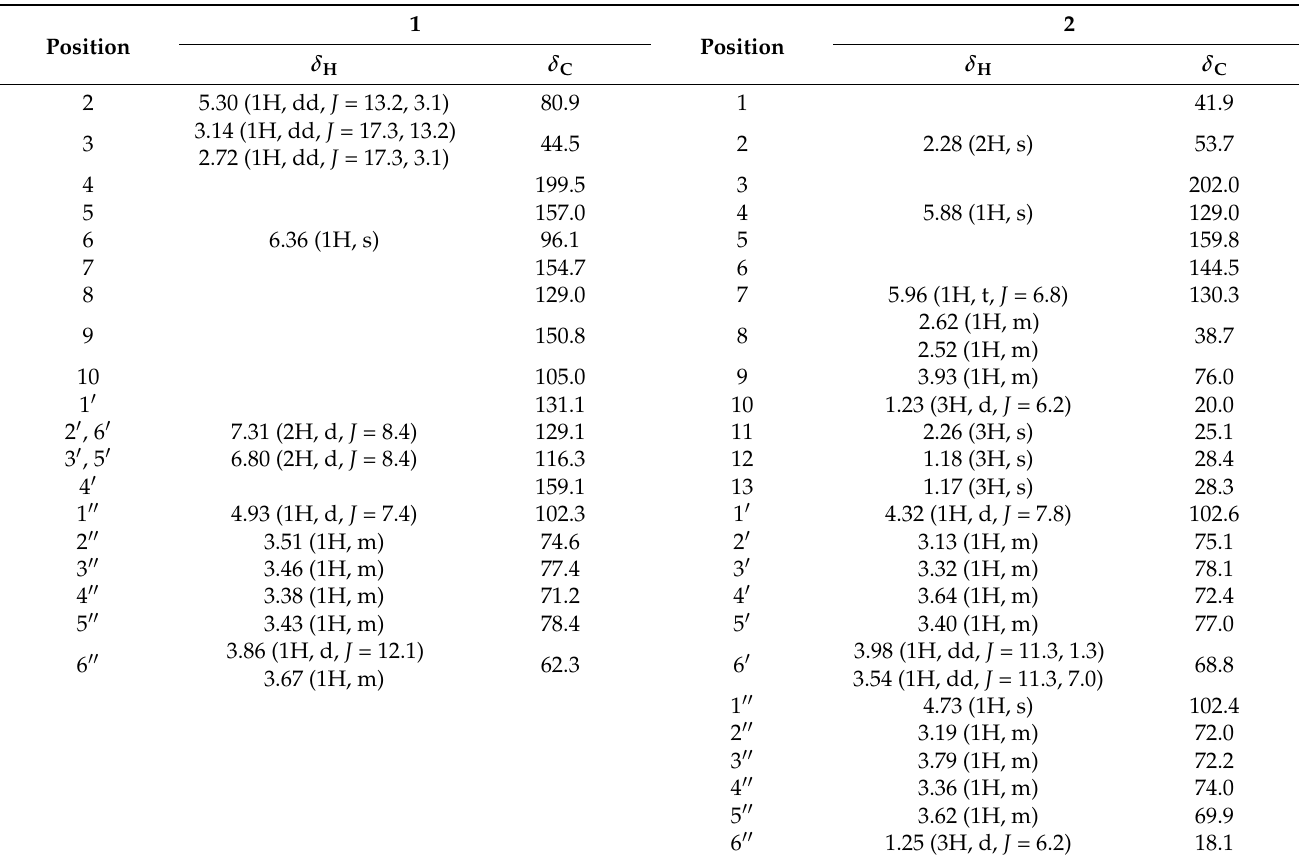
Table 1. 1 H NMR and 13 C NMR data of compounds 1 – 2 ( δ in ppm, J in Hz) in CD 3